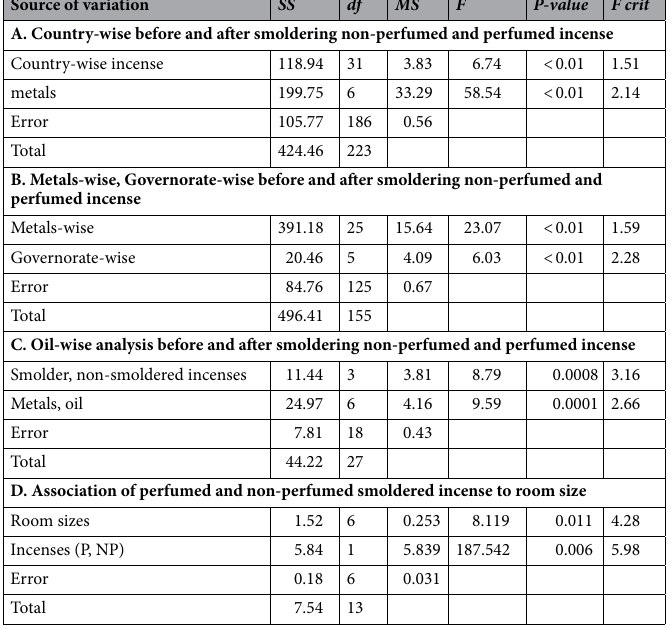
Table 1. ANOVA tests on the smoldered and non-smoldered non-perfumed and perfumed incense. SS sum of squares, df degree of freedom, MS mean square, F calculated value, P-value for significance, F crit F critical table value, P, NP perfumed and non-perfumed incenses.